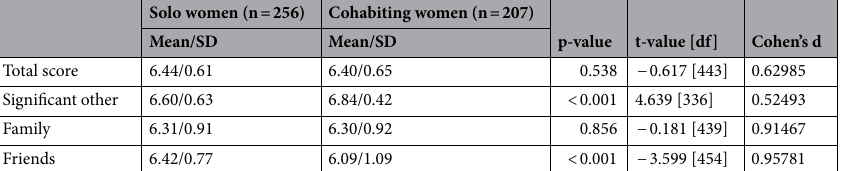
Solo women (n = 256) Cohabiting women (n =